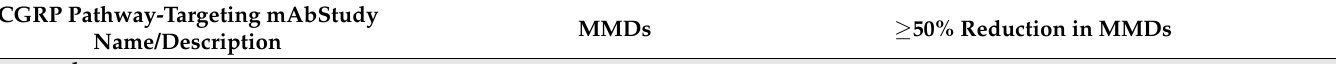
CGRP Pathway-Targeting